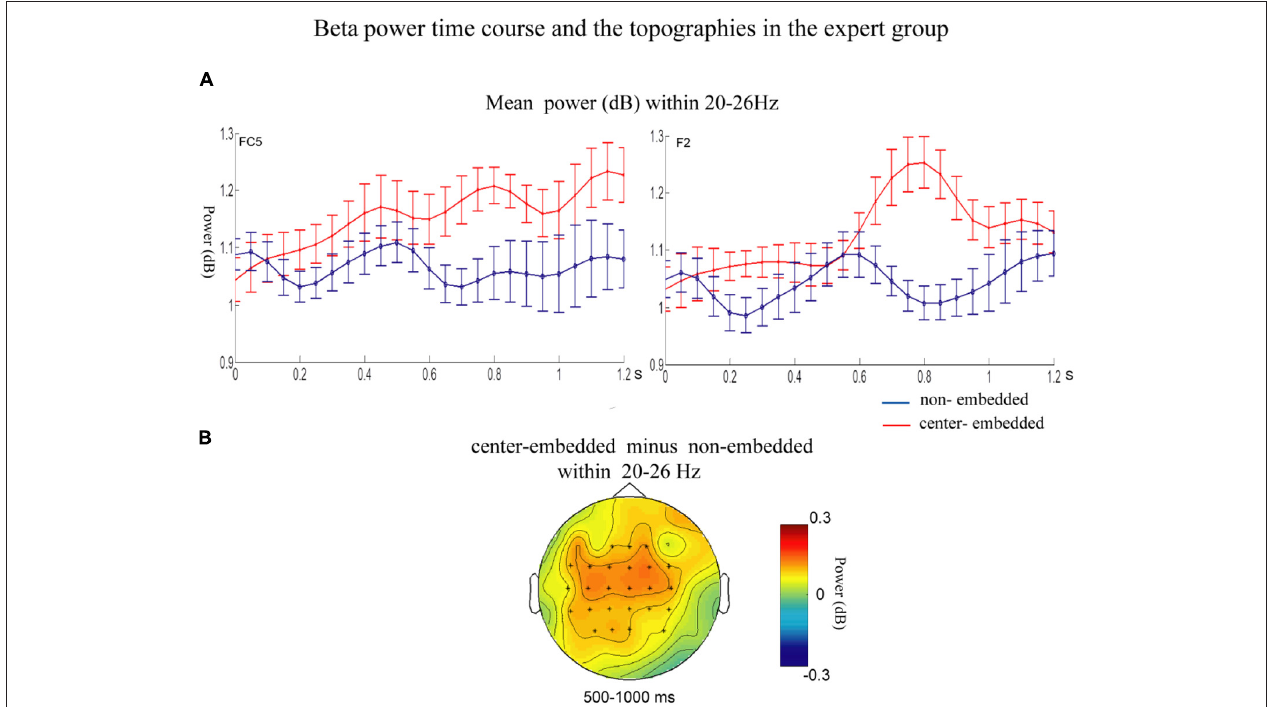
FIGURE 7 | Time course of the mean beta power and difference topographies of final chords in the expert group. (A) Temporal course of the mean beta power (20–26 Hz) between 0 ms and 1,200 ms after the onset of the final chords for the non-embedded and center-embedded conditions at electrodes FC5 and F2. Error bars indicate standard errors. (B) The difference topographies (center-embedded minus embedded) in the beta band (20–26 Hz) within 500–1,000 ms. The electrodes that showed significant effects over 30% of the selected time intervals were marked by